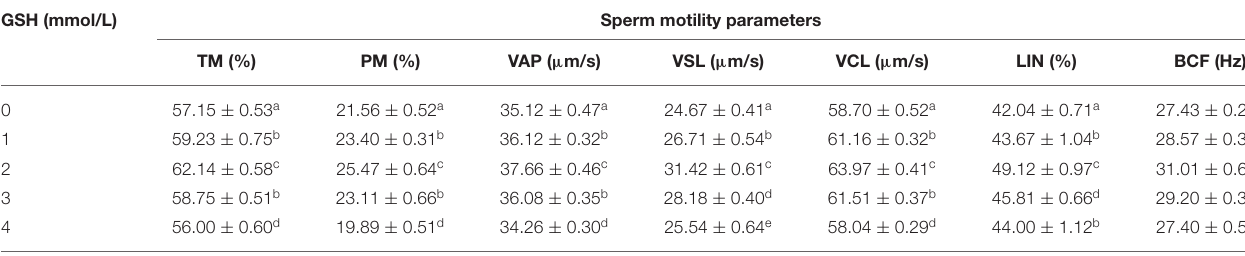
TABLE 1 | Effect of glutathione (GSH) on sperm motility parameters of Guanzhong dairy goats after thawing. GSH (mmol/L)